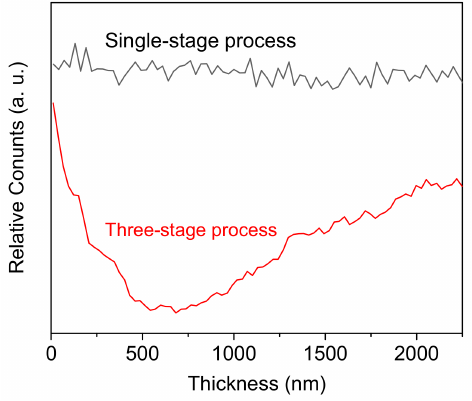
Figure 8. SIMS depth profiles of Ga distribution for the CIGS films prepared by the single-stage and three-stage processes.